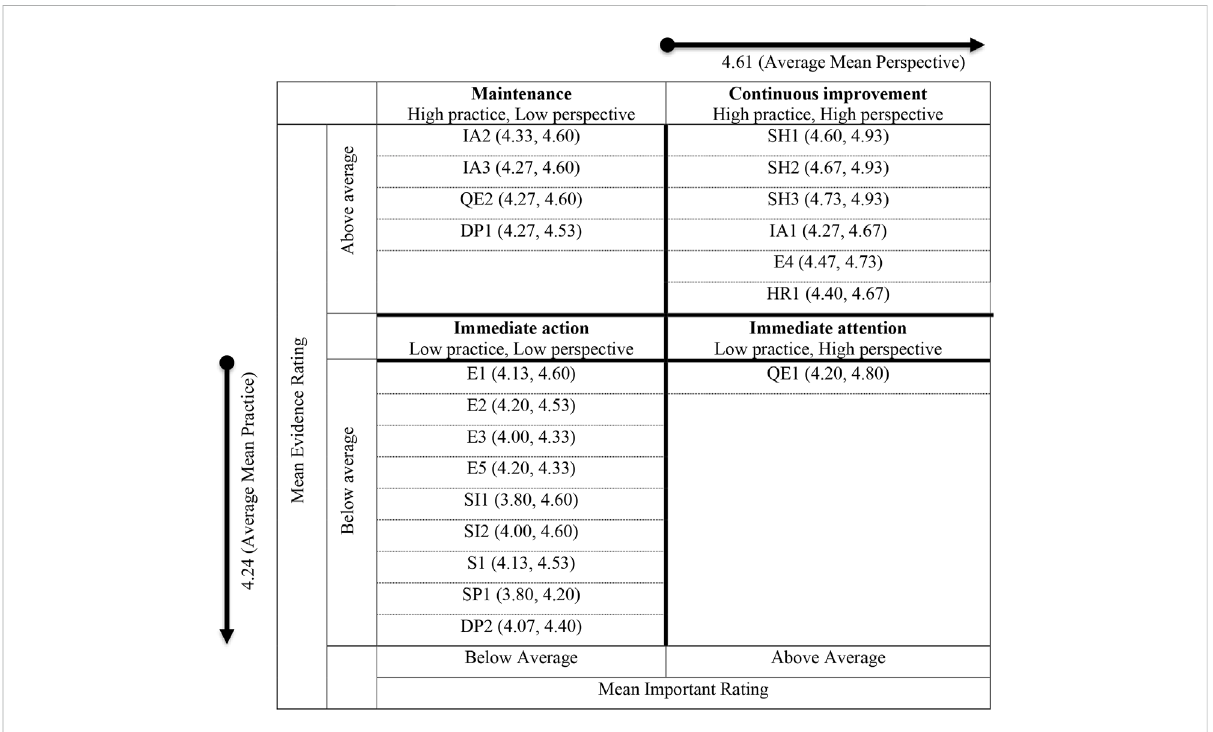
FIGURE 4 Perspective-Practice Competencies Quadrant